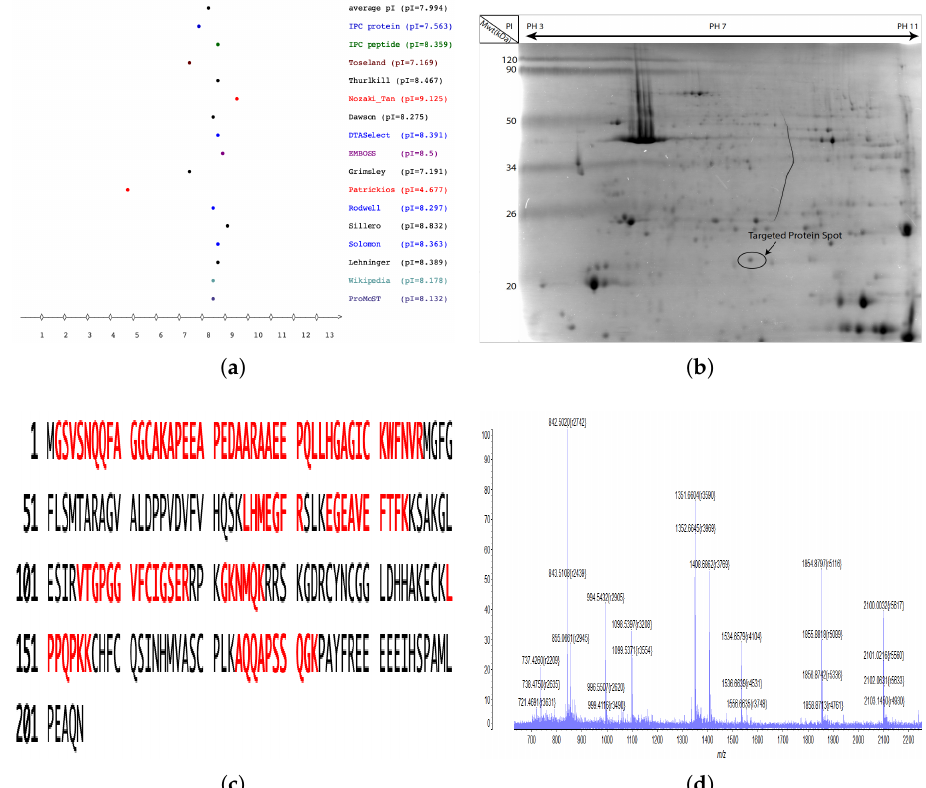
Table 2, the peptide mass profiles were retrieved from NCBIprot database search engine, and the amino acid sequence of each digested peptide was recognized from the sequence of cLin-28 protein from the extracted spot of this protein on the 2-DE gel. The PMF-MS results also aligned with those from other species; the second best matching protein had a score of 120 for alpaca (accession no. XP_006196877.1) Lin-28 protein. The third and fourth best matching proteins also scored with 120 for pig (accession no.